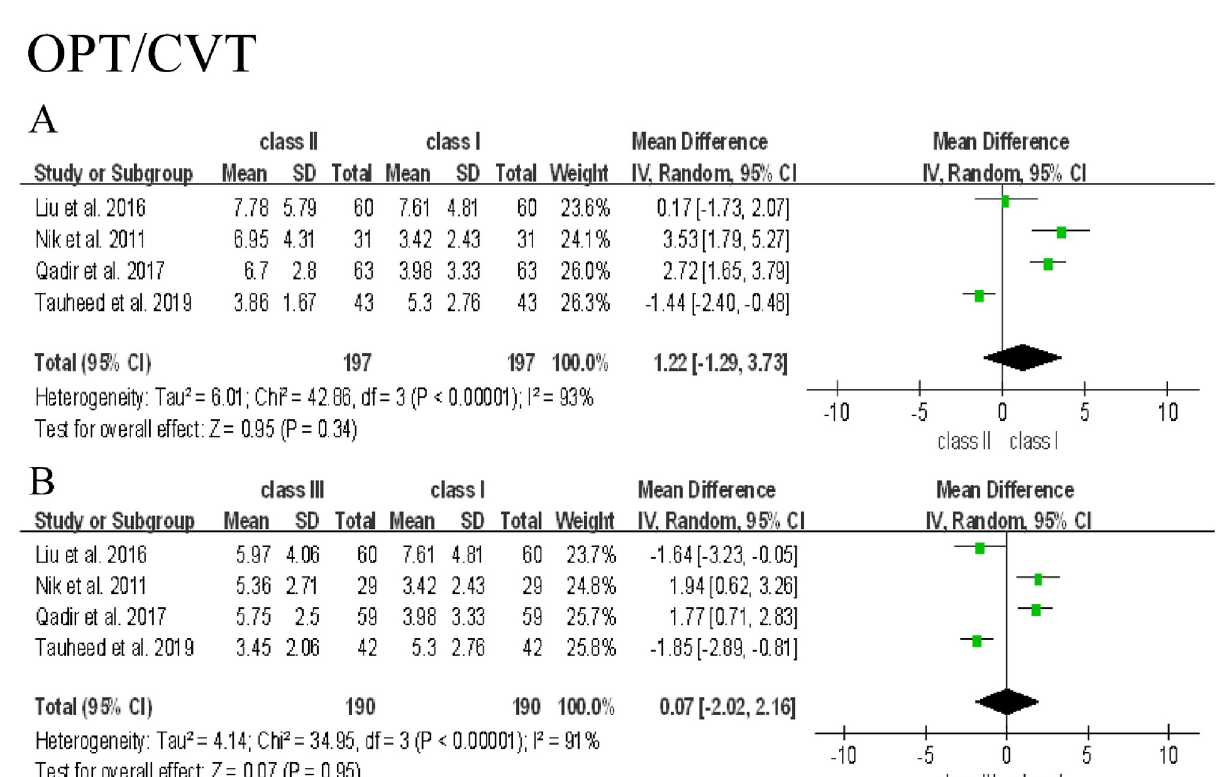
ity (Fig 3D) among the groups, the result of OPT/HOR in Class II group as well as the changes of CVT/HOR both in Class II and Class III groups showed no significant differences compared to Class I group.